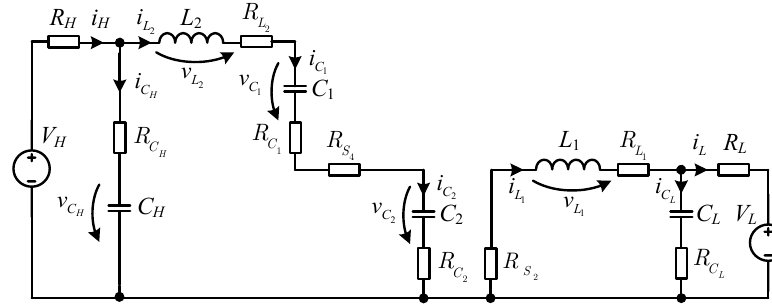
Figure 16. Equivalent BHSC schematic, derived from Figure 14, for t off . The input and input vector are defined as follows: